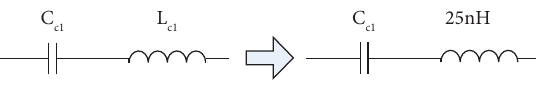
Figure 18: Adjust the frst branch of RCN.